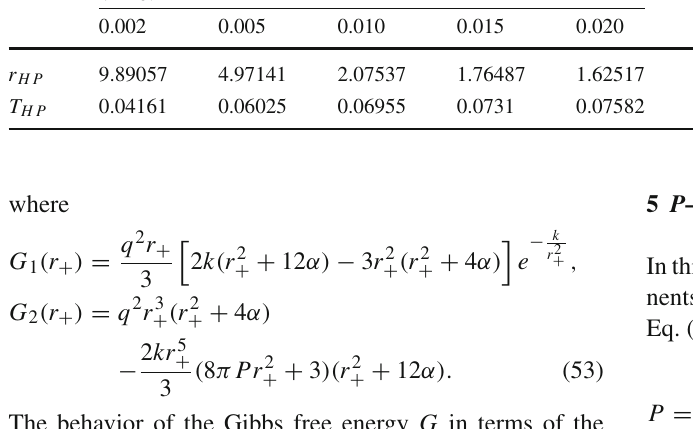
Fig. 7 Plots of the Gibbs free energy, scaled by 16 π/ S 3 , in terms of the event horizon radius, at α = 0 . 5 and k = 0 . 4. The blue, green, red, and purple curves correspond to P = 0 . 002, 0.003, 0.009, 0.02, respectively Table 2 The numerical results for the radius r HP and the temperature T HP at the Hawking–Page phase transition, under the different values of the √ pressure and the nonlinear parameter, at α = 0 . 5 and q = 2 P k = 0 . 4 k = 0 .